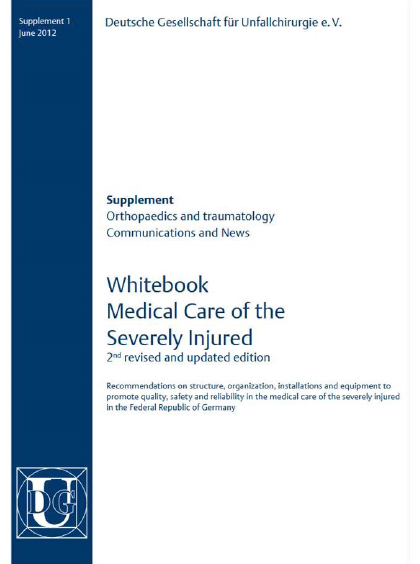
Figure 1. Cover Whitebook DGU . ©AUC GmbH/DGU